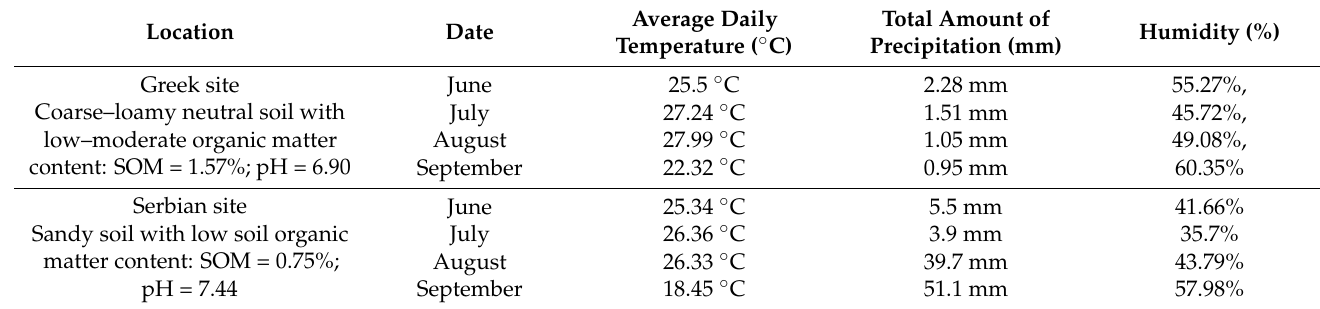
Table 4. Summary of meteorological data at the semi-filed trial locations